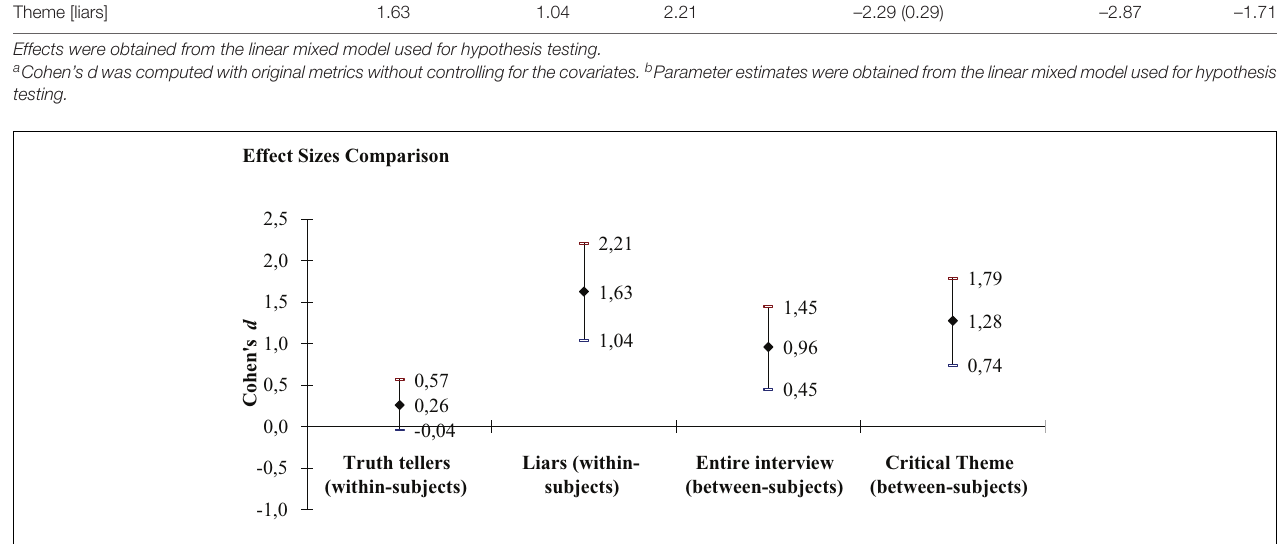
FIGURE 1 | Comparison of between-subjects and within-subjects effect sizes, with 95% confidence intervals. Cohen’s d was computed with original metrics without controlling for the covariates. TABLE 2 | Means, standard deviations, and 95% confidence intervals for the factor “Theme” obtained from the linear mixed model used for hypothesis testing. 95% C.I. 95% C.I.